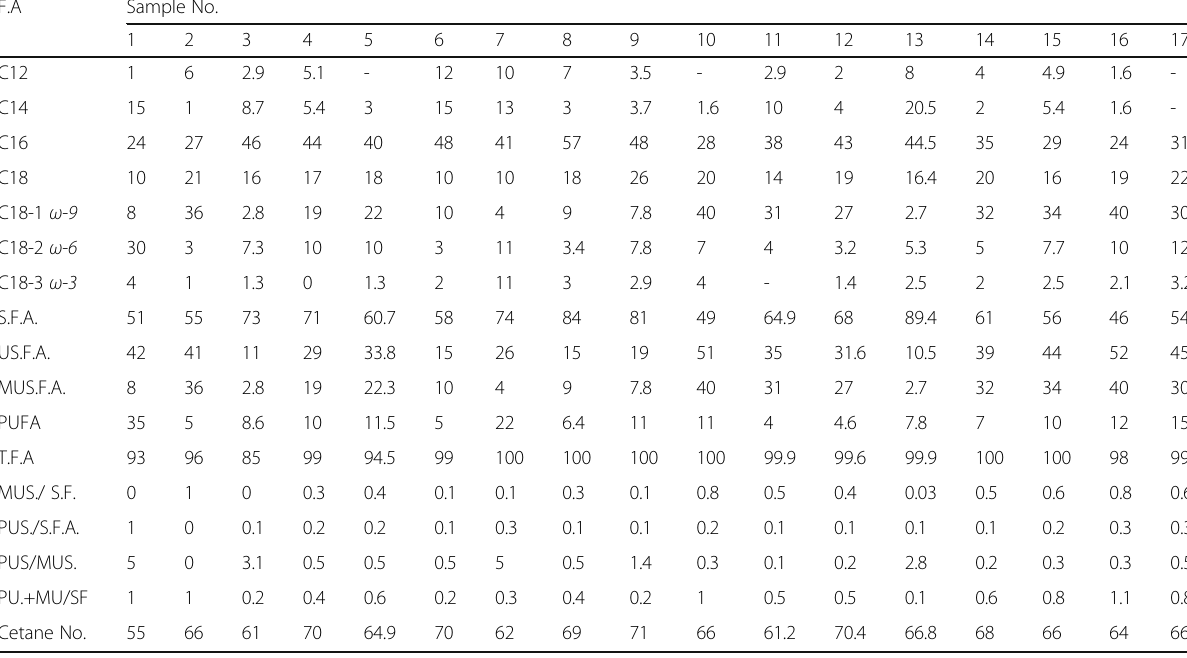
Table 4 The fatty acid profile and cetane No. of oil in samples cultivated under different treatments F.A Sample